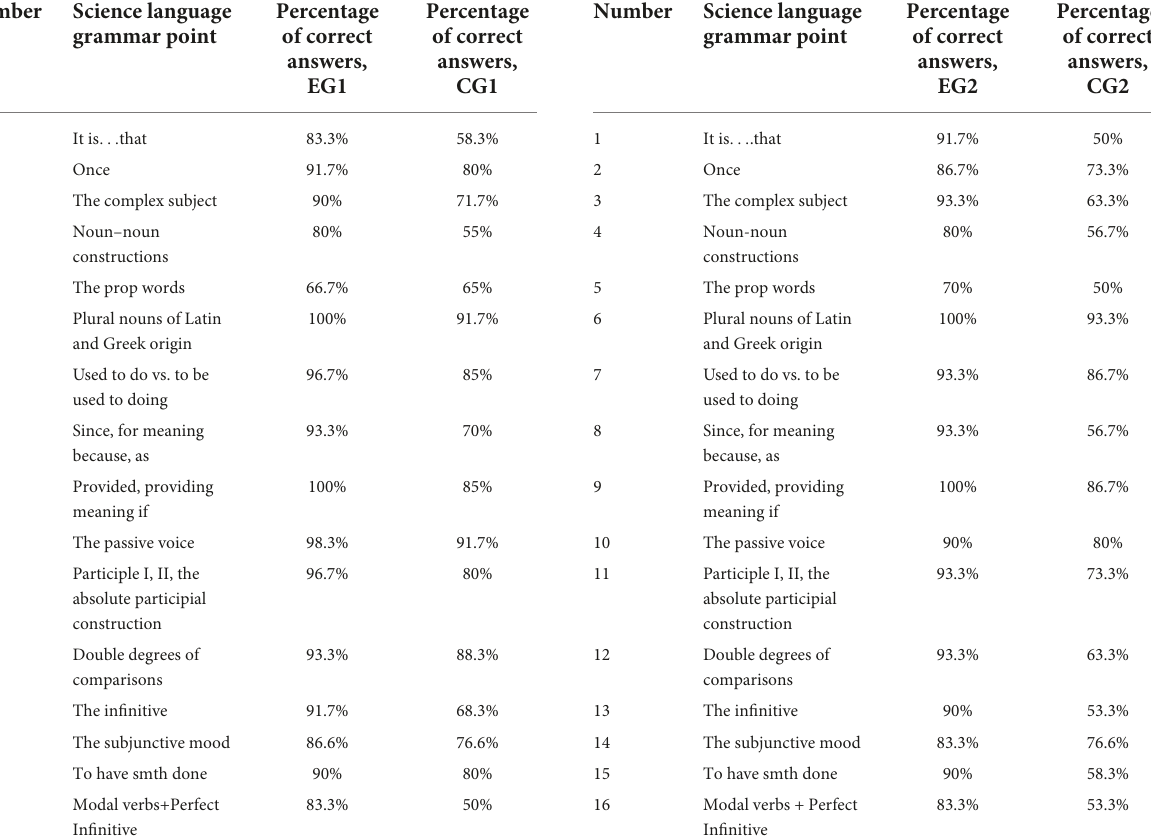
TABLE 4 End of the term results of Science language grammar course 2019–2020 academic year.